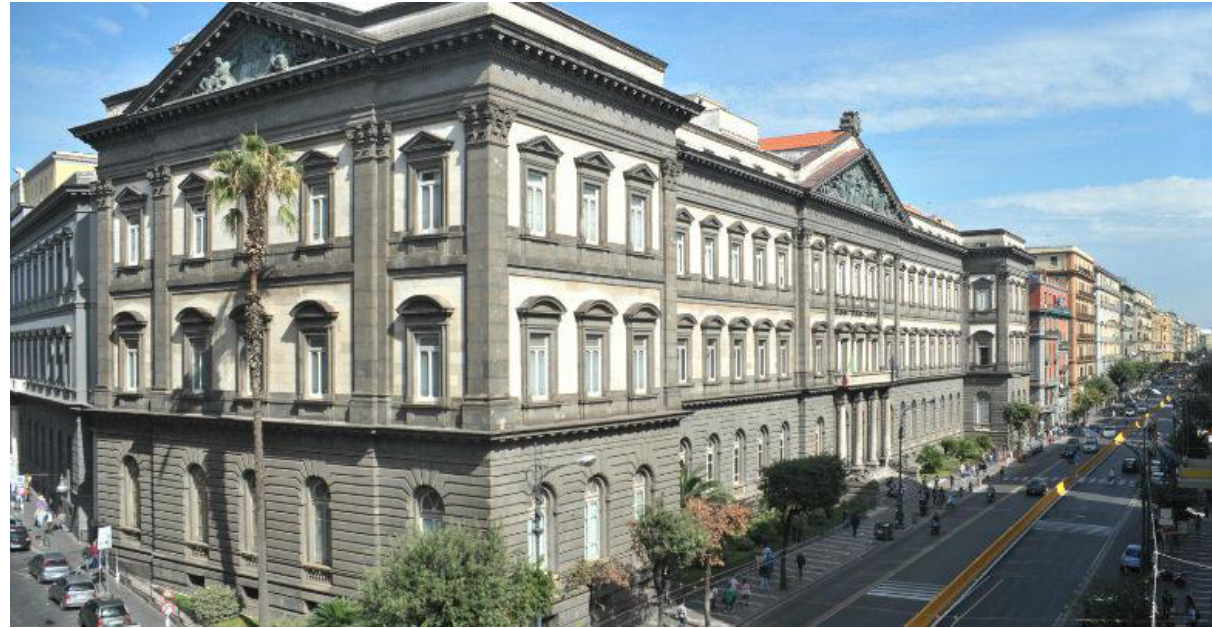
Figure 2. Naples. The front of the Federico II building on corso Umberto I